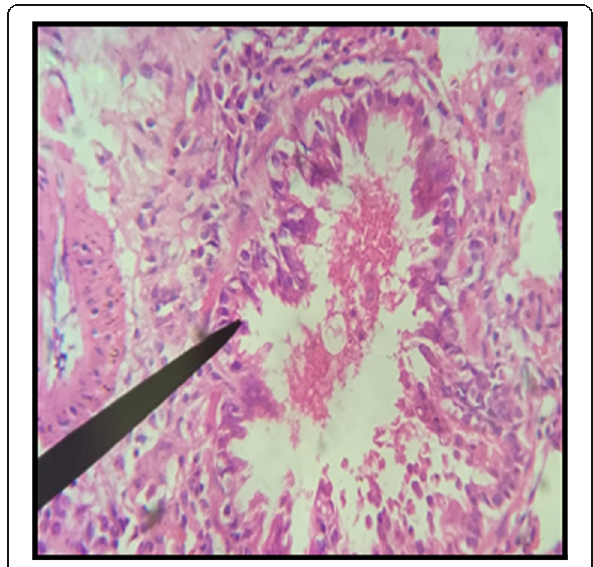
Fig. 17 Liver Section of Male Rat (200 mg/kg/day) X400. a infiltration of inflammatory cells in central vein, b destructive sinusoids